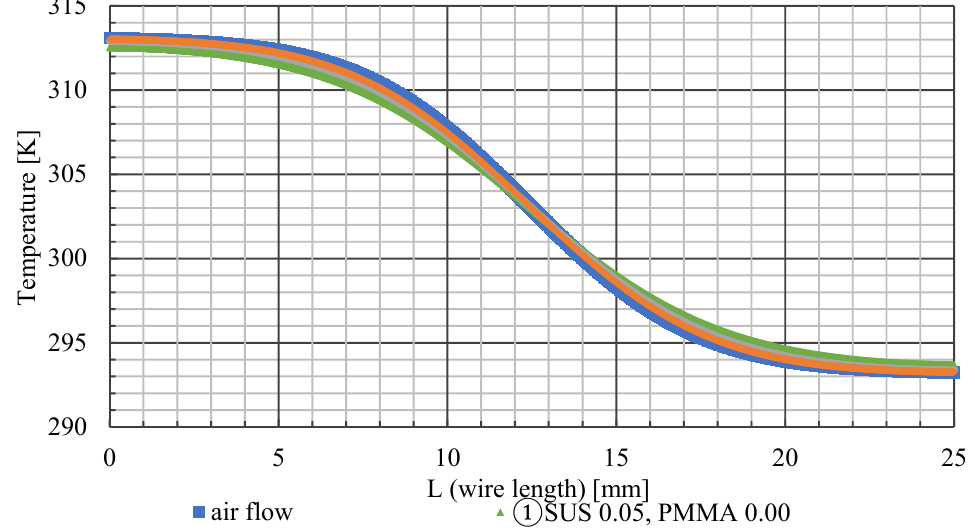
Figure 8. Temperature on wire surface.